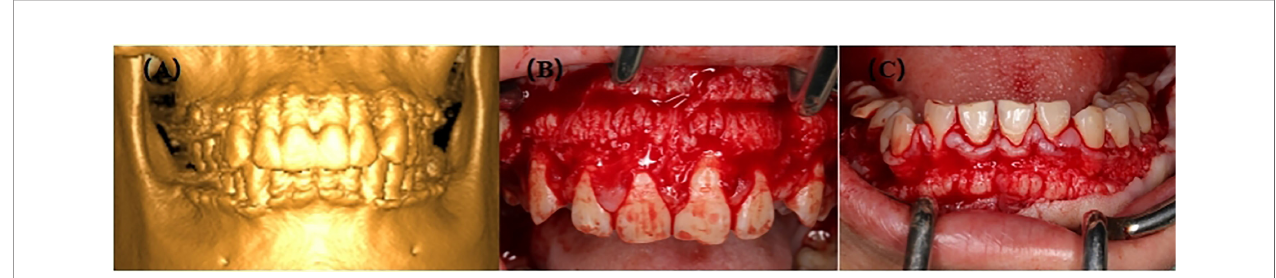
FIGURE 2 | (A) 3D image of III-2; (B) Preoperative picture of maxilla from III-2; (C) Preoperative picture of mandible from